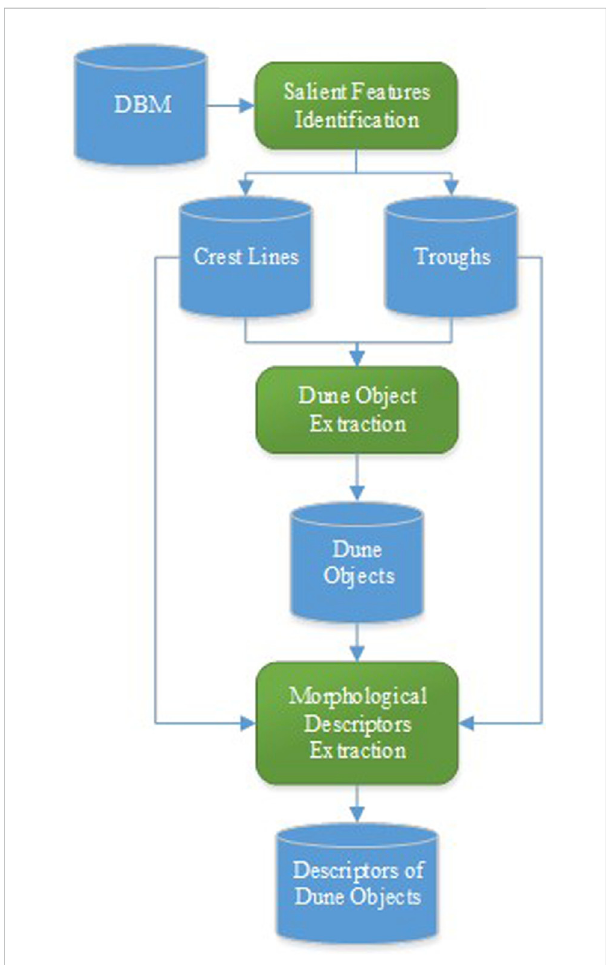
FIGURE 5 Approach for the automatic segmentation and characterization of dune objects from a DBM. Adapted from Cassol et al. (2022b). Reproduced under